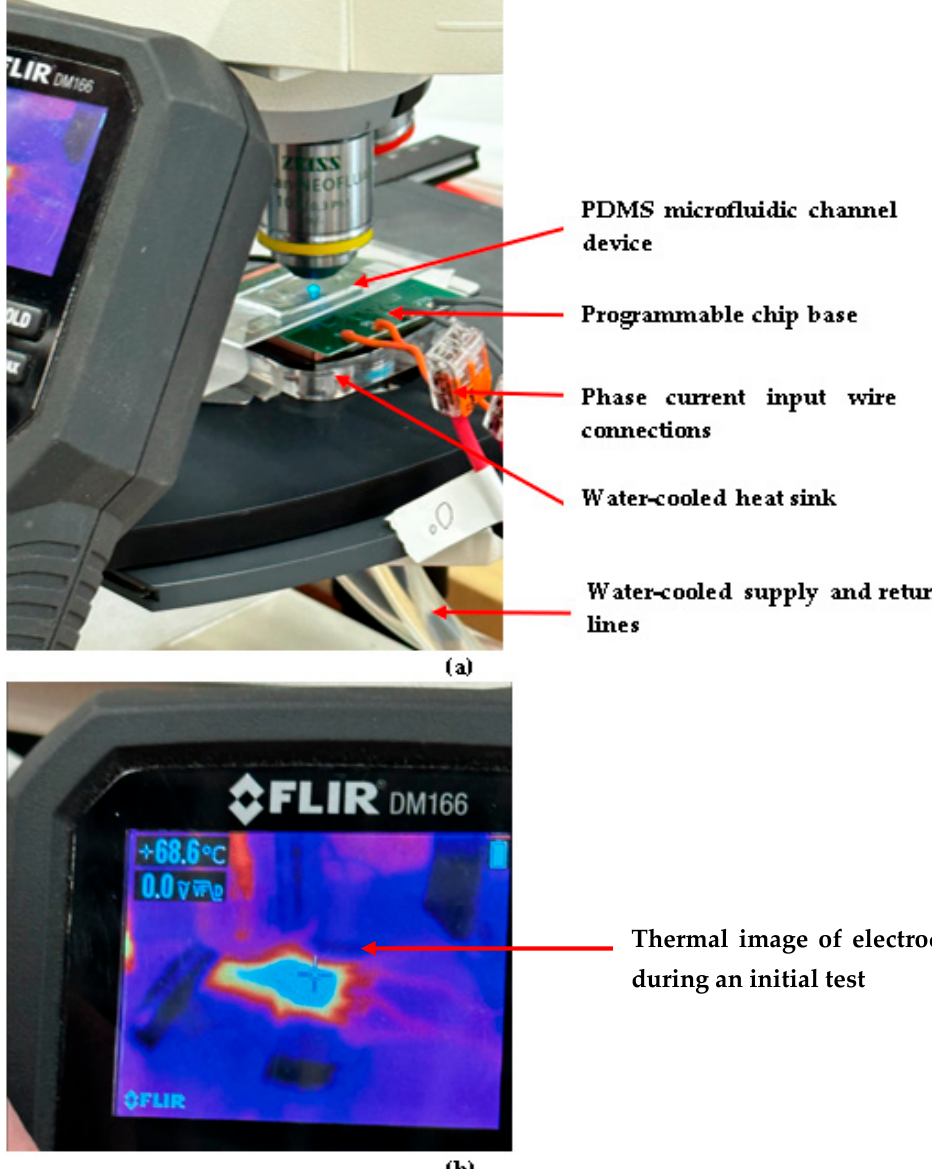
Figure 5. System rig and water-cooled heat dissipation setup: ( a ) full system with the ferro-microfluidic device and water block and ( b ) the thermal image of the electrodes with an input current.